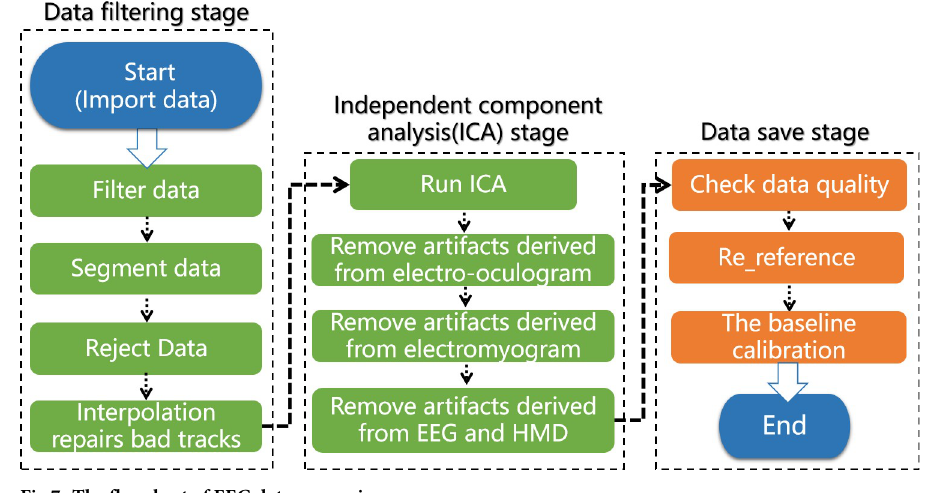
Fig 7. The flowchart of EEG data